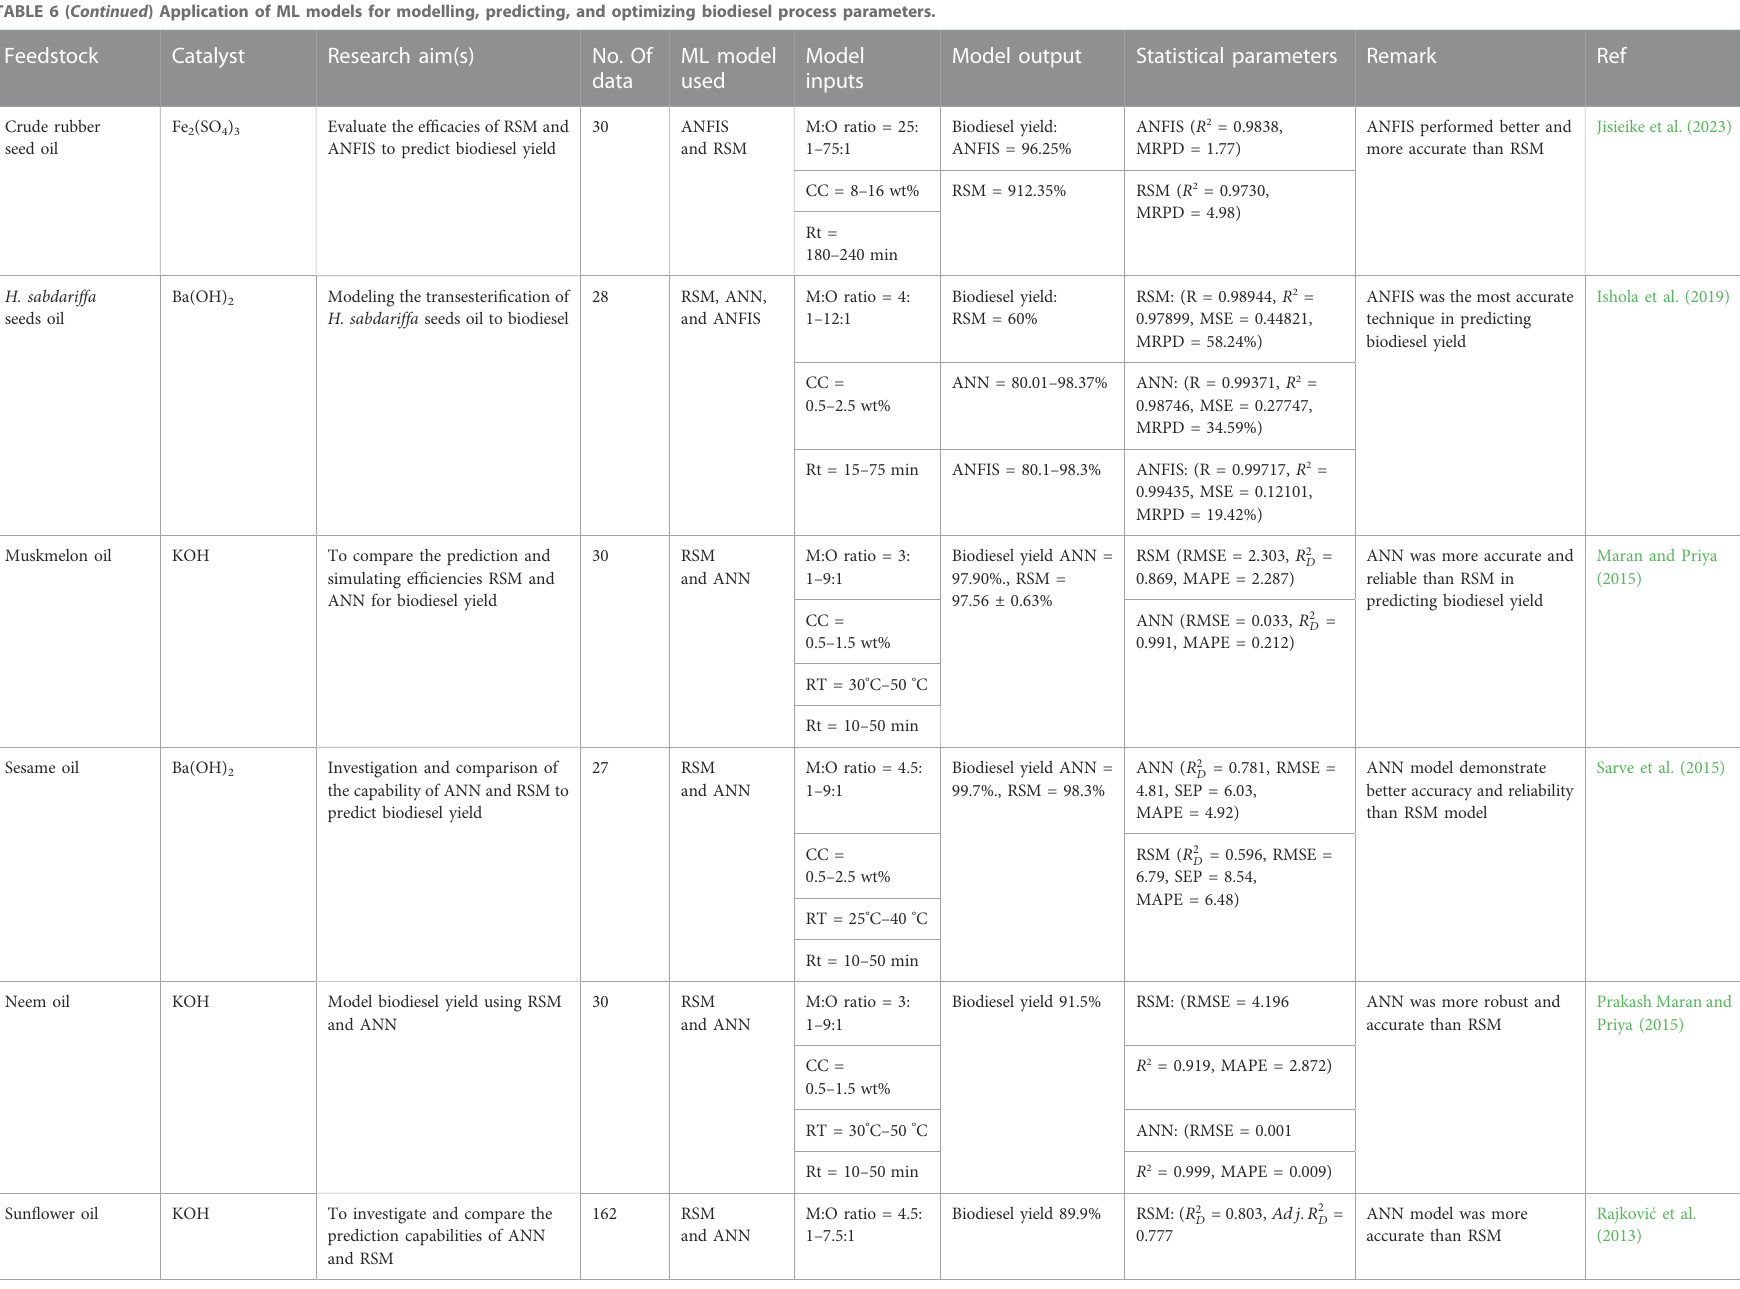
TABLE 6 ( Continued ) Application of ML models for modelling, predicting, and optimizing biodiesel process